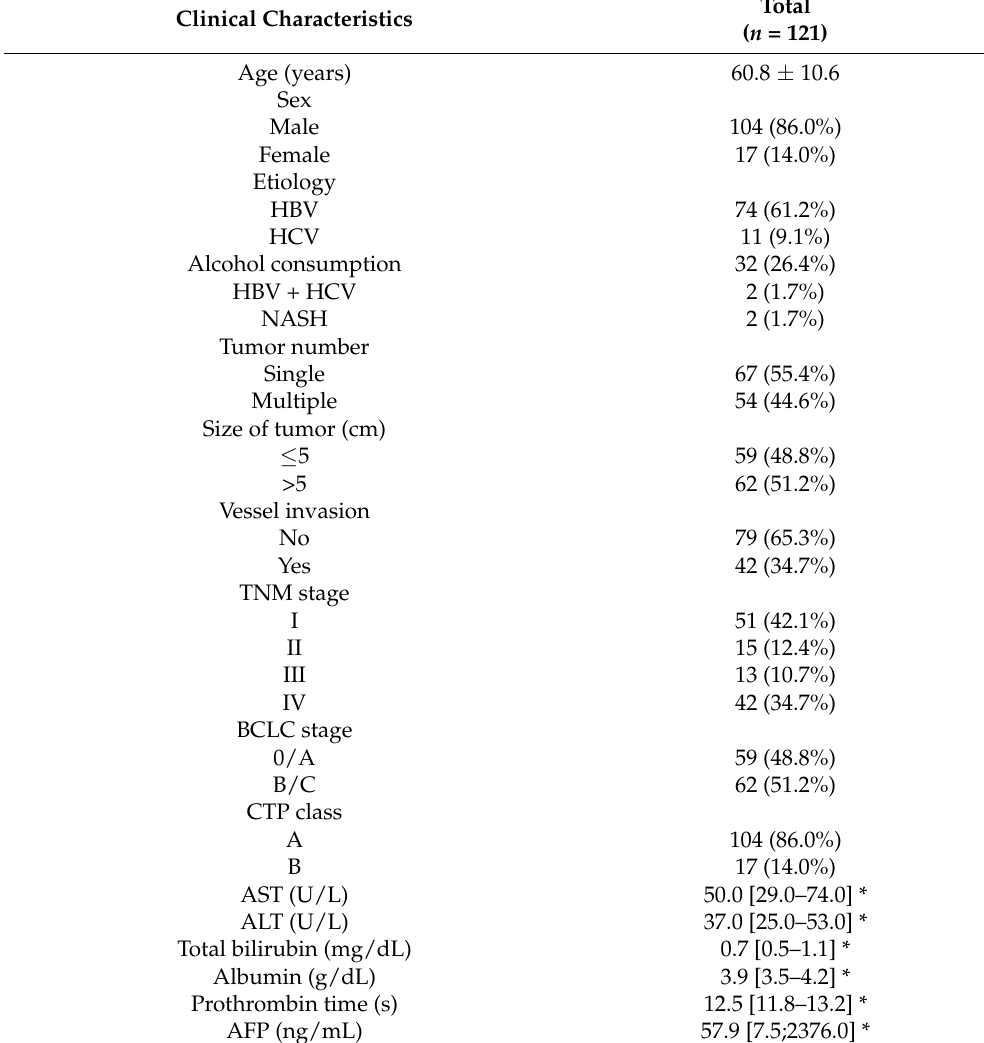
Table 1. Baseline characteristics of enrolled